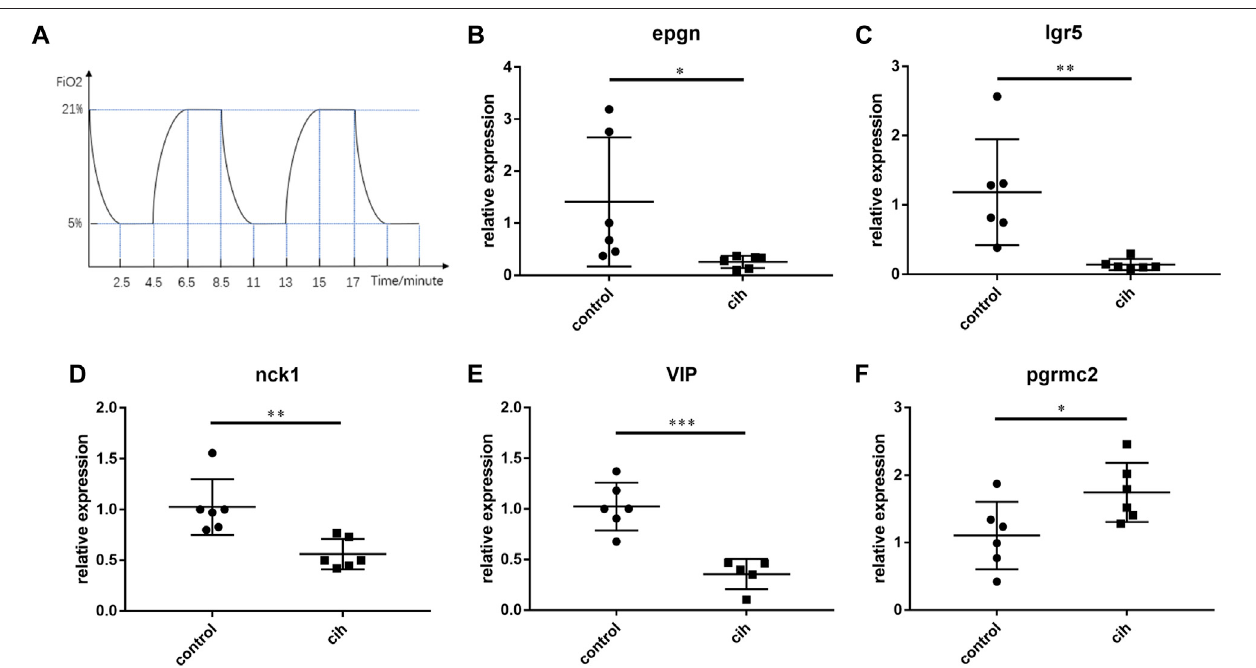
FIGURE 11 | The expression trend of prognostic factors after 4 weeks of chronic intermittent hypoxia (CIH). (A) The fl ow chart of CIH exposure procedure. The expression of EPGN (B) , IGR5 (C) , NCK1 (D) , VIP (E) , and PGRMC2 (F) . Data are presented as means ± SEM, n (cid:1) 6 for each group. * p < 0.05, * * p < 0.01 and * * * p < 0.001 compared with control